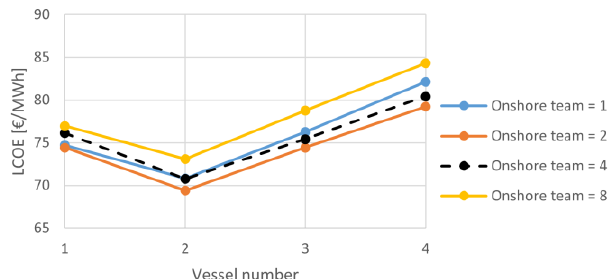
Fig. 25. LCOE versus vessel number for various numbers of onshore teams, in the case of c/d time=1 hr and assembly team=3.